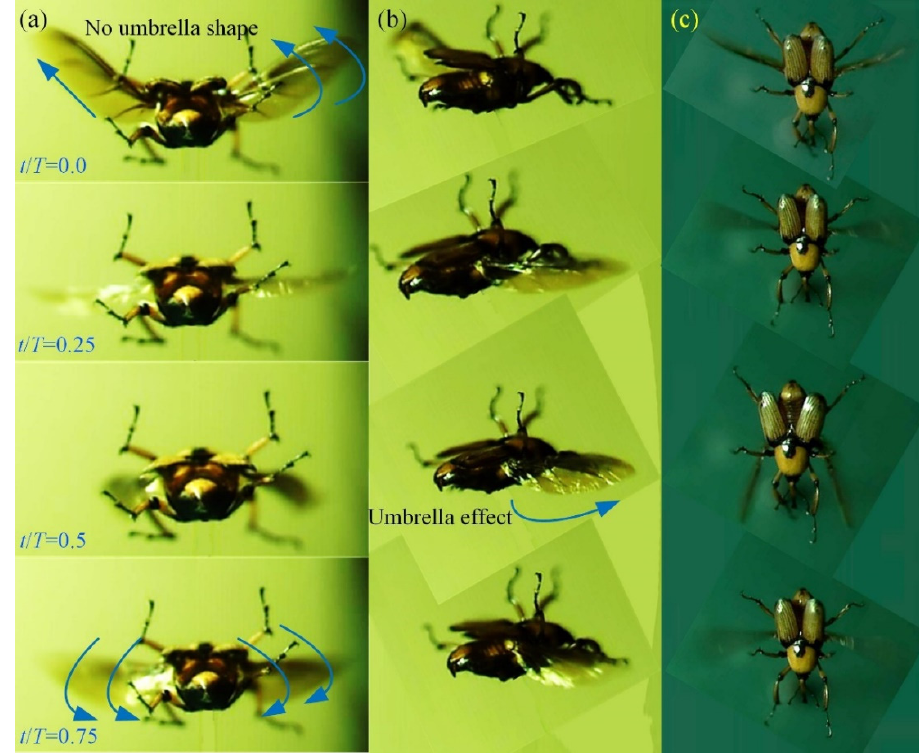
Figure 2. Four stages of the flapping wing cycle. ( a ) Front view. ( b ) Right view. ( c ) Aerial view. The wing kinematics parameters are obtained from captured video frames. The time- consuming nature of the upstroke and downstroke motions is almost the same. The forward velocity was 2 m/s with zero degrees with respect to the body angle. A wing beat cycle has 30 frames, which means that the flapping frequency is about 67 Hz. The inclination angle of the flapping plane with respect to the horizontal direction is approximately 36 ± 1.3 ◦ for hovering flight. The flapping-wing amplitude ( φ ) of the hindwings is 70 ± 3.6 ◦ . The range of variations in the deviation angle ( θ ) is from − 40 ◦ to 42 ◦ . Angles θ (t) and α (t)